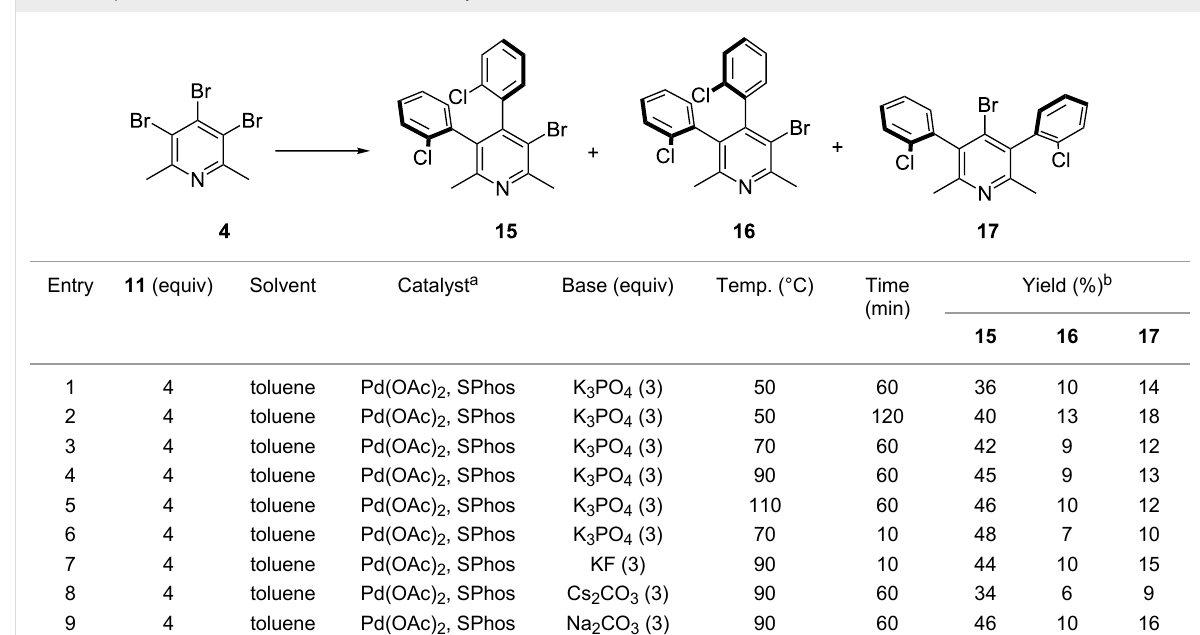
Table 5: Optimization of the reaction conditions for the synthesis of 15 – 17 .